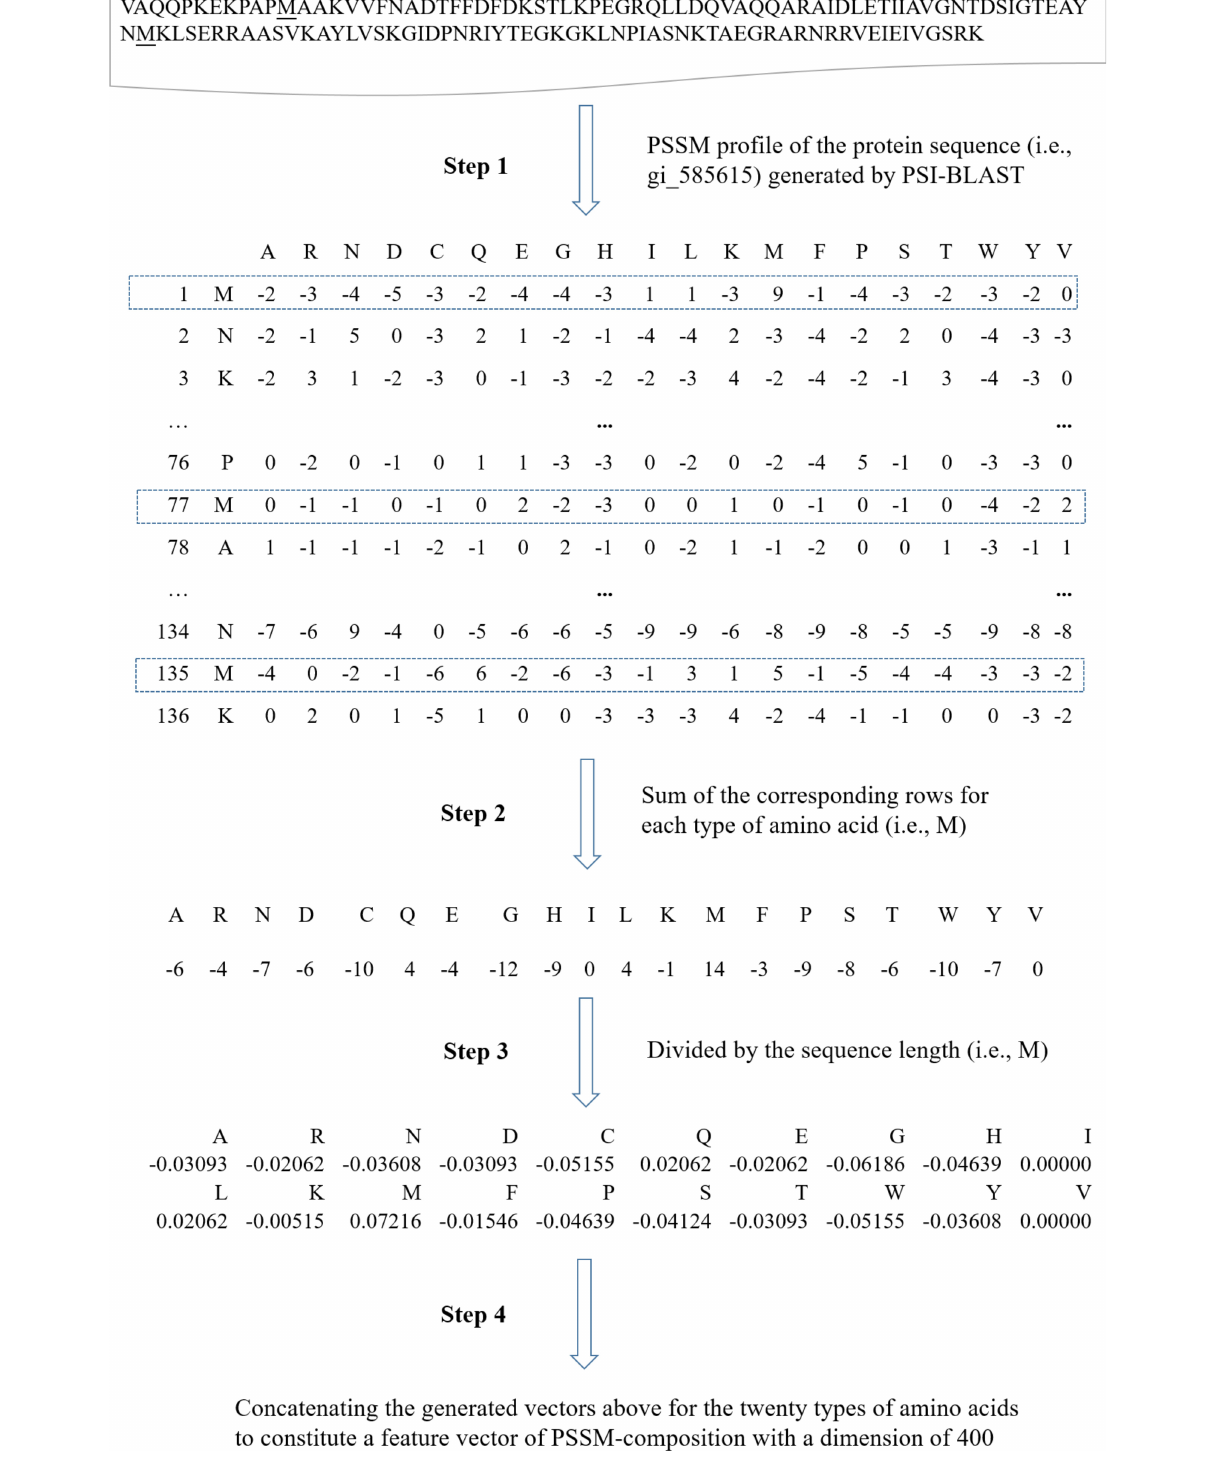
FIGURE 1 | The illustration of PSSM-composition profile calculation for a query